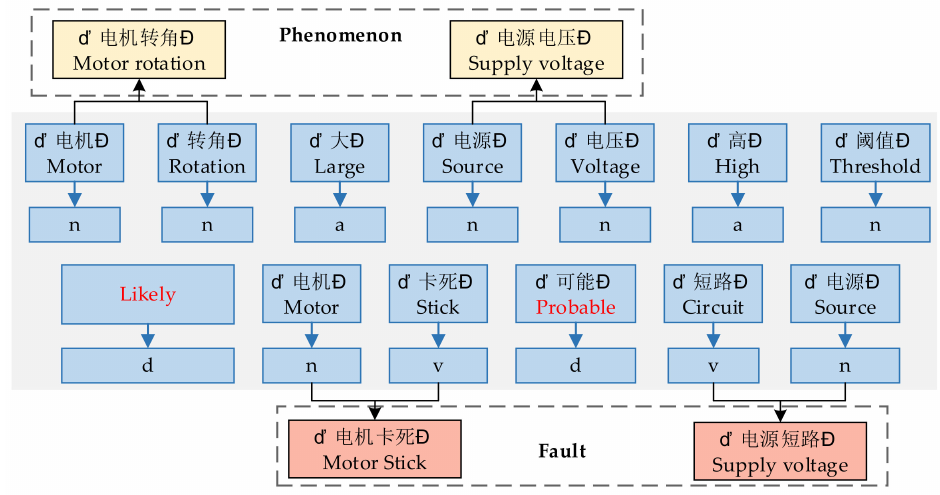
Figure 5. The attribute phrase and fault cause